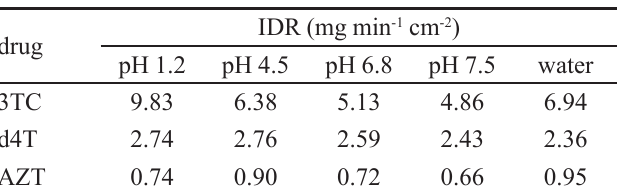
TABLE IV - Intrinsic dissolution rate (IDR) of 3TC, d4T and